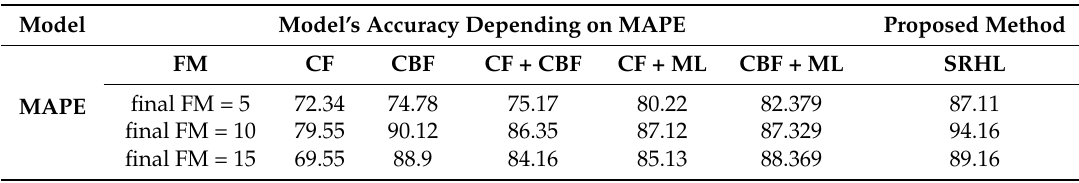
Table 9. Recommendation accuracy by MAPE.